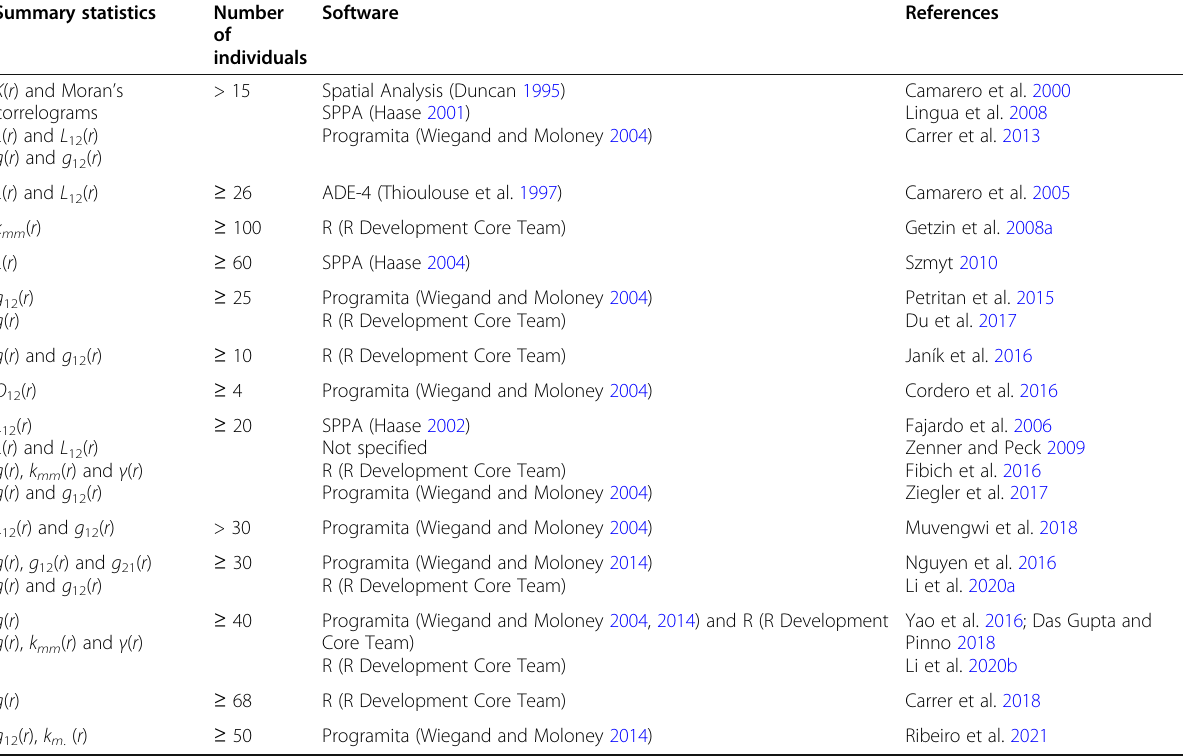
Table 2 Examples of the minimum number of individuals (trees) and software used in spatial point-pattern analyses. Most studies used a very low number of trees in SPPA which does not correspond to the recommendations provided by the main textbooks related to